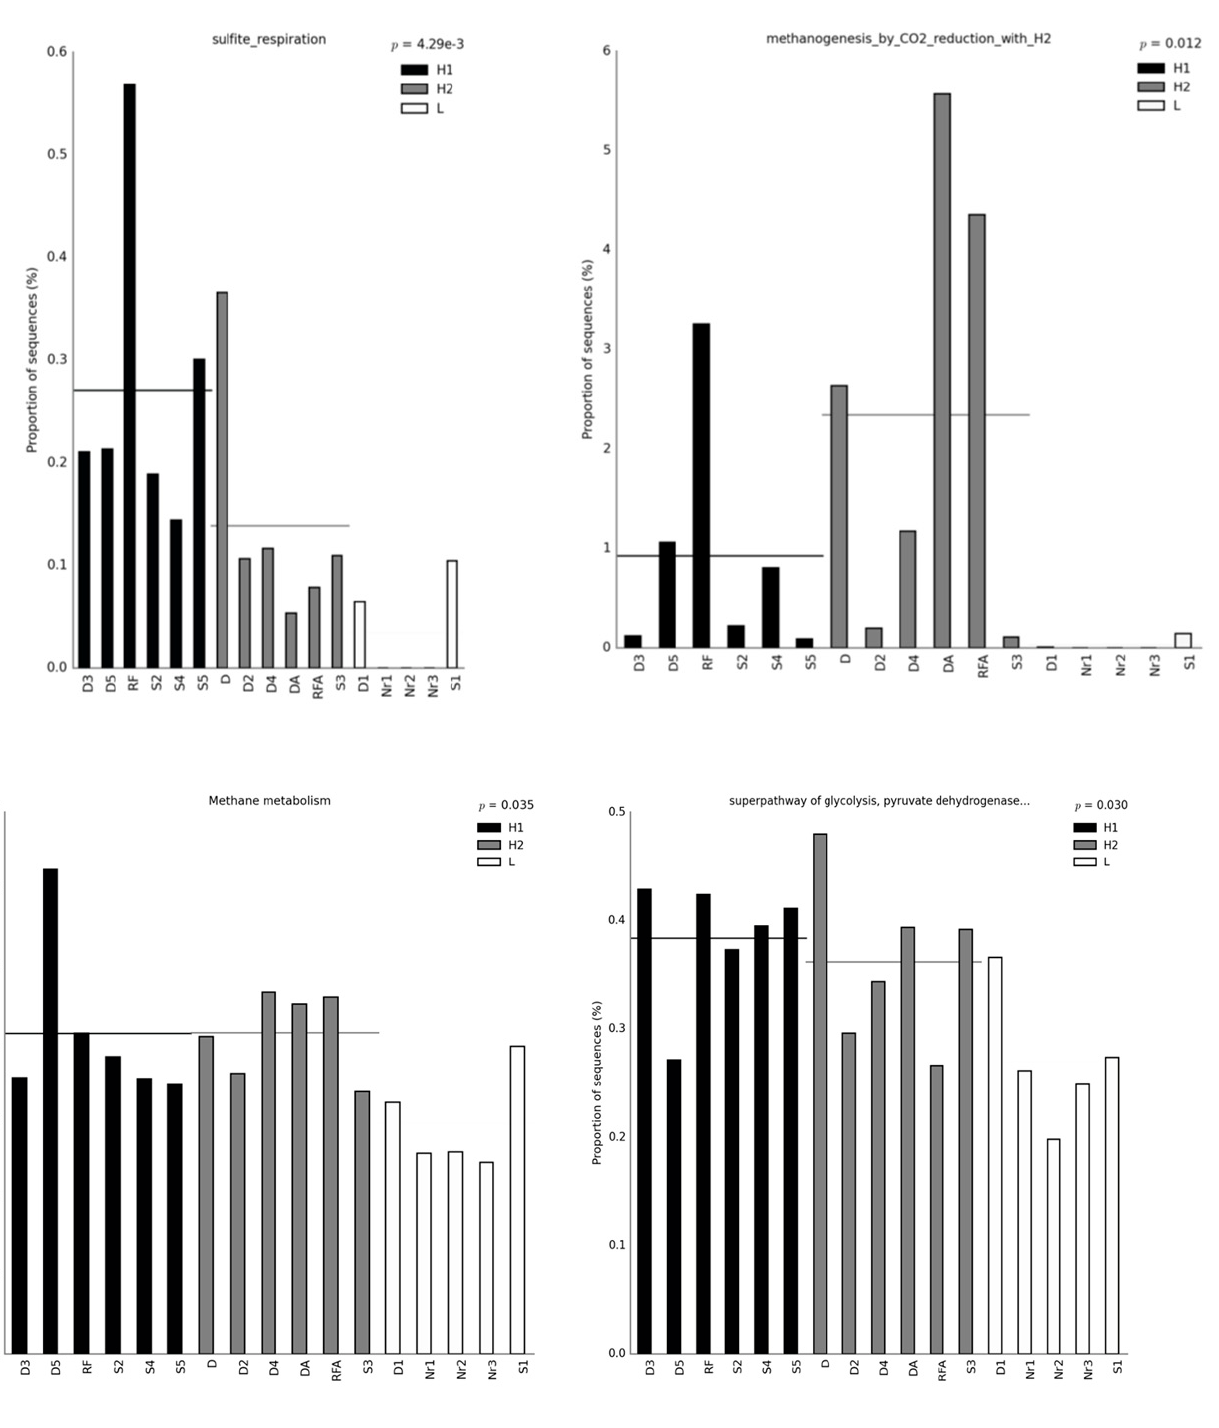
Figure 3. Bar plots of the functional features related to energy metabolism. The x-axis indicates the samples grouped into three groups. H1 represents the voltage outputs of soils larger than 50 mV with black. H2 represents the voltage outputs of the soils lower than 50 mV with gray. L represents the soils without MFCs processing with white. The y-axis indicates the relative abundance. The horizontal line crossing the bar represents the